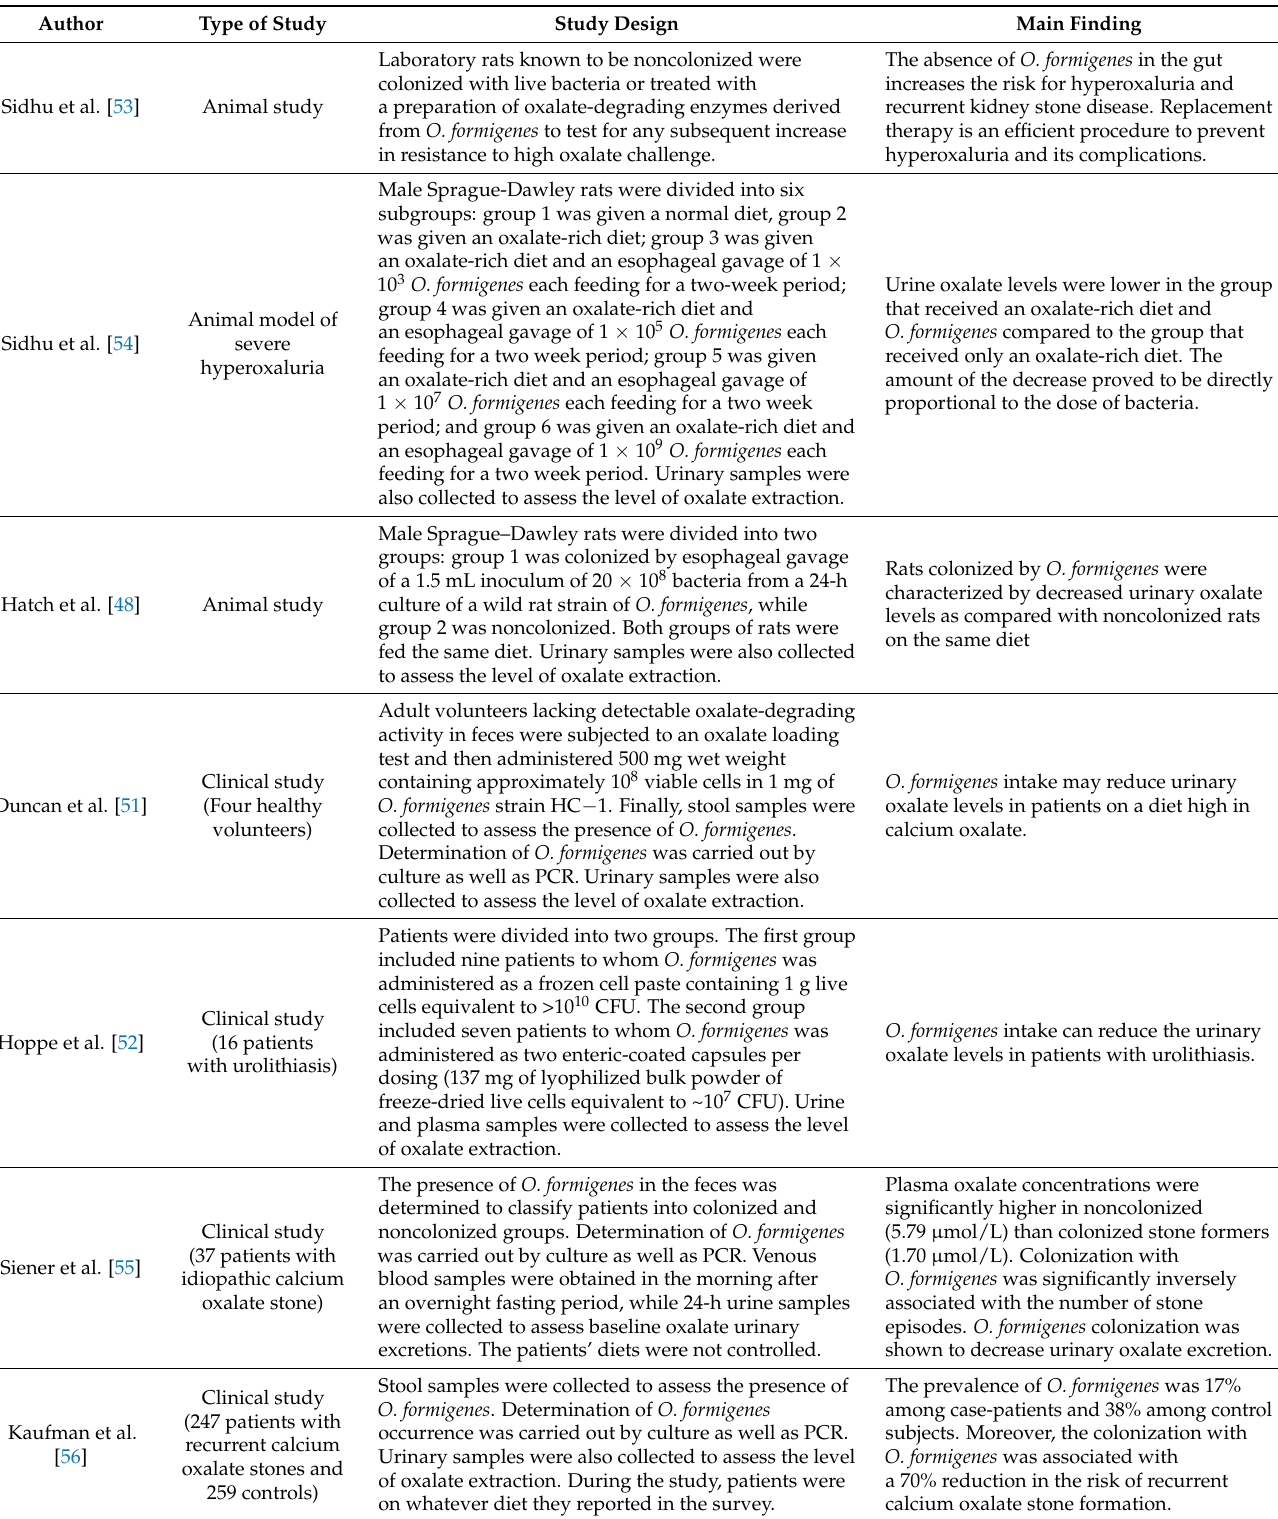
Table 3. A summary of previous studies on the use of O. formigenes for the prevention of